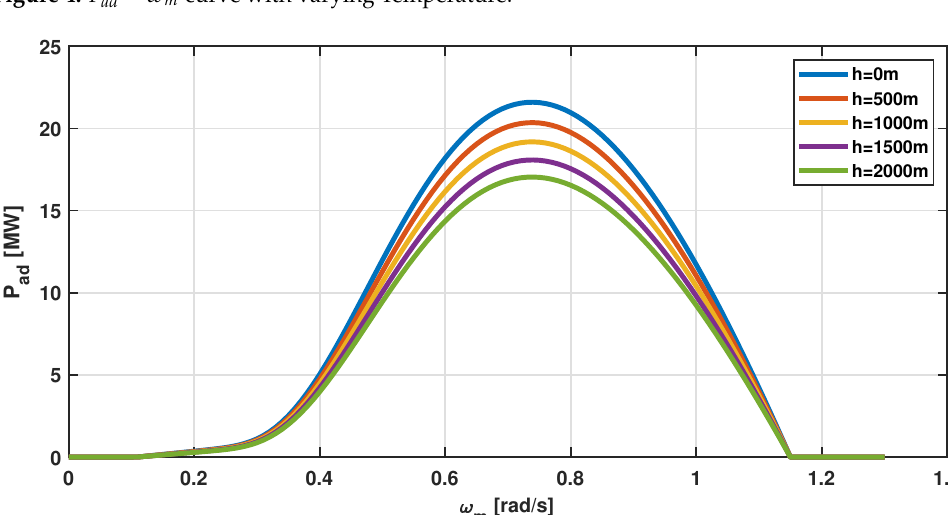
Figure 5. P ad − ω m curve with varying